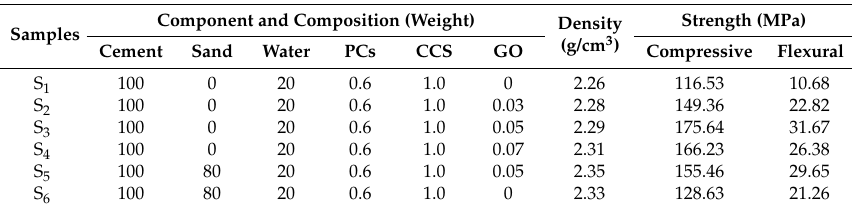
Table 2. Components and ratios of cement